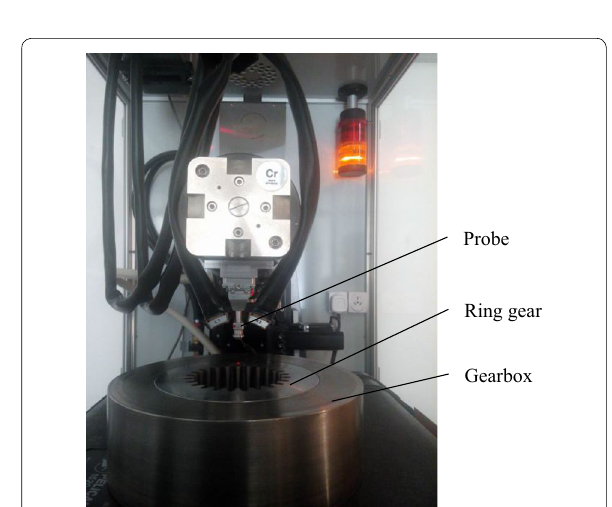
Figure 5 LXRD X-ray